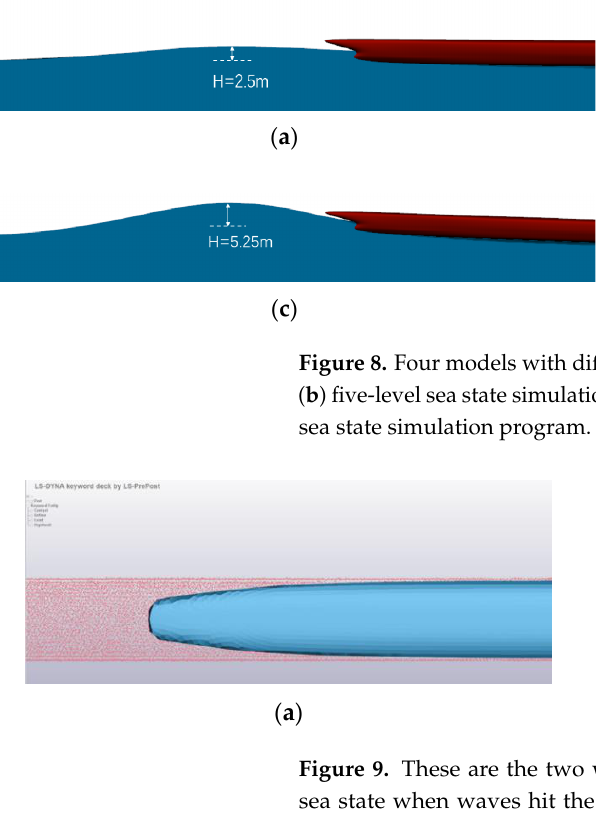
Figure 9. These are the two working conditions of Scenario 1: ( a ) conditions in the fourth-level sea state when waves hit the hull and ( b ) conditions when the fourth-level sea state’s sea spray parti- cles settle.